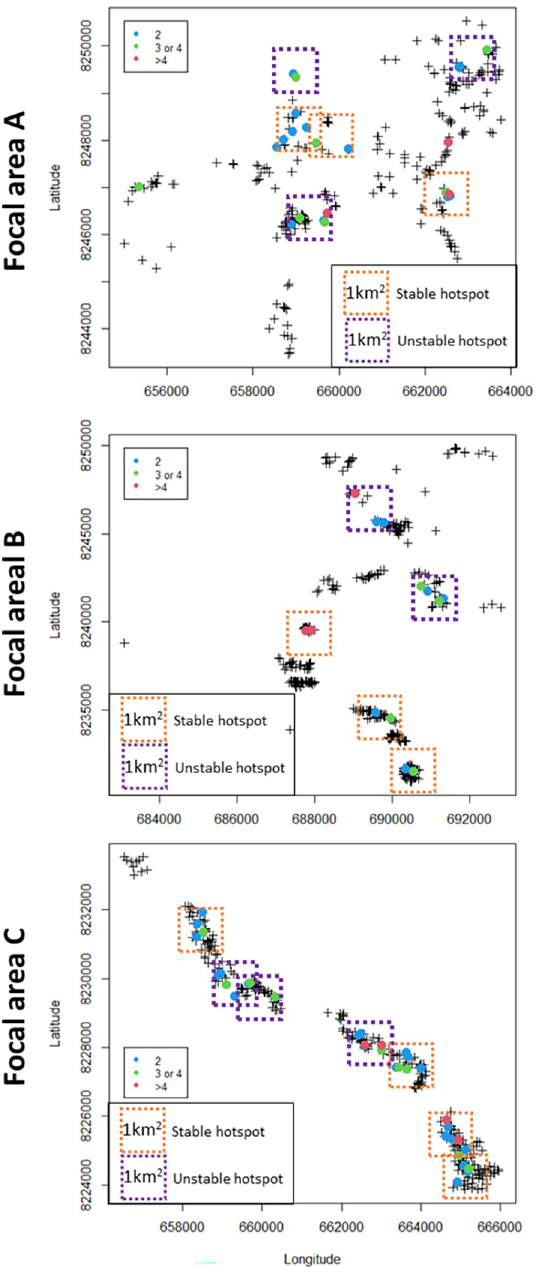
Fig 3. Location of super-spreader houses and hotspots (stable and unstable) within each focal area. Each colour denotes the number of ‘infected houses’ arising from the spreader. A black cross denotes the location of an uninfected house. Allocation of the hotspots has been performed manually capturing the largest number of super-spreaders within each hotspot square.